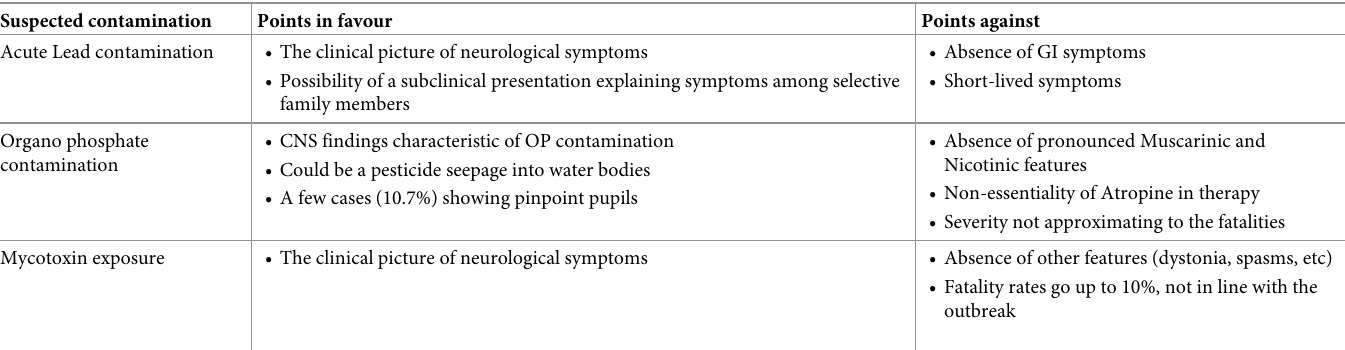
Table 1. Differential